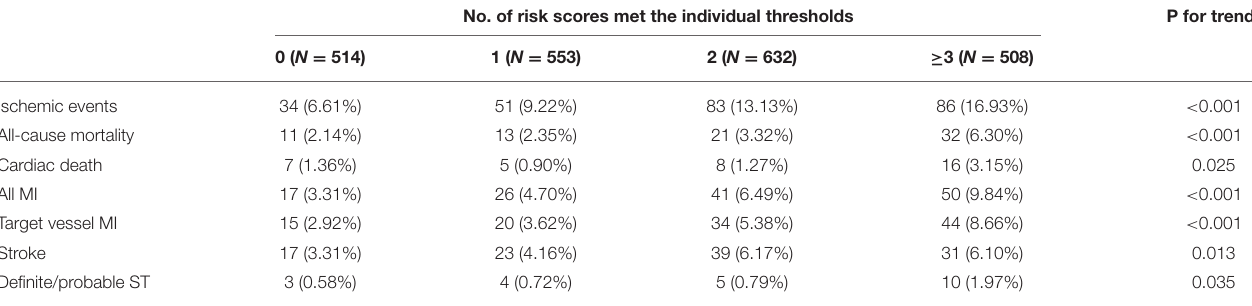
TABLE 3 | Clinical outcomes at 4-year follow-up stratified across cumulative risk-score categories. No. of risk scores met the individual thresholds